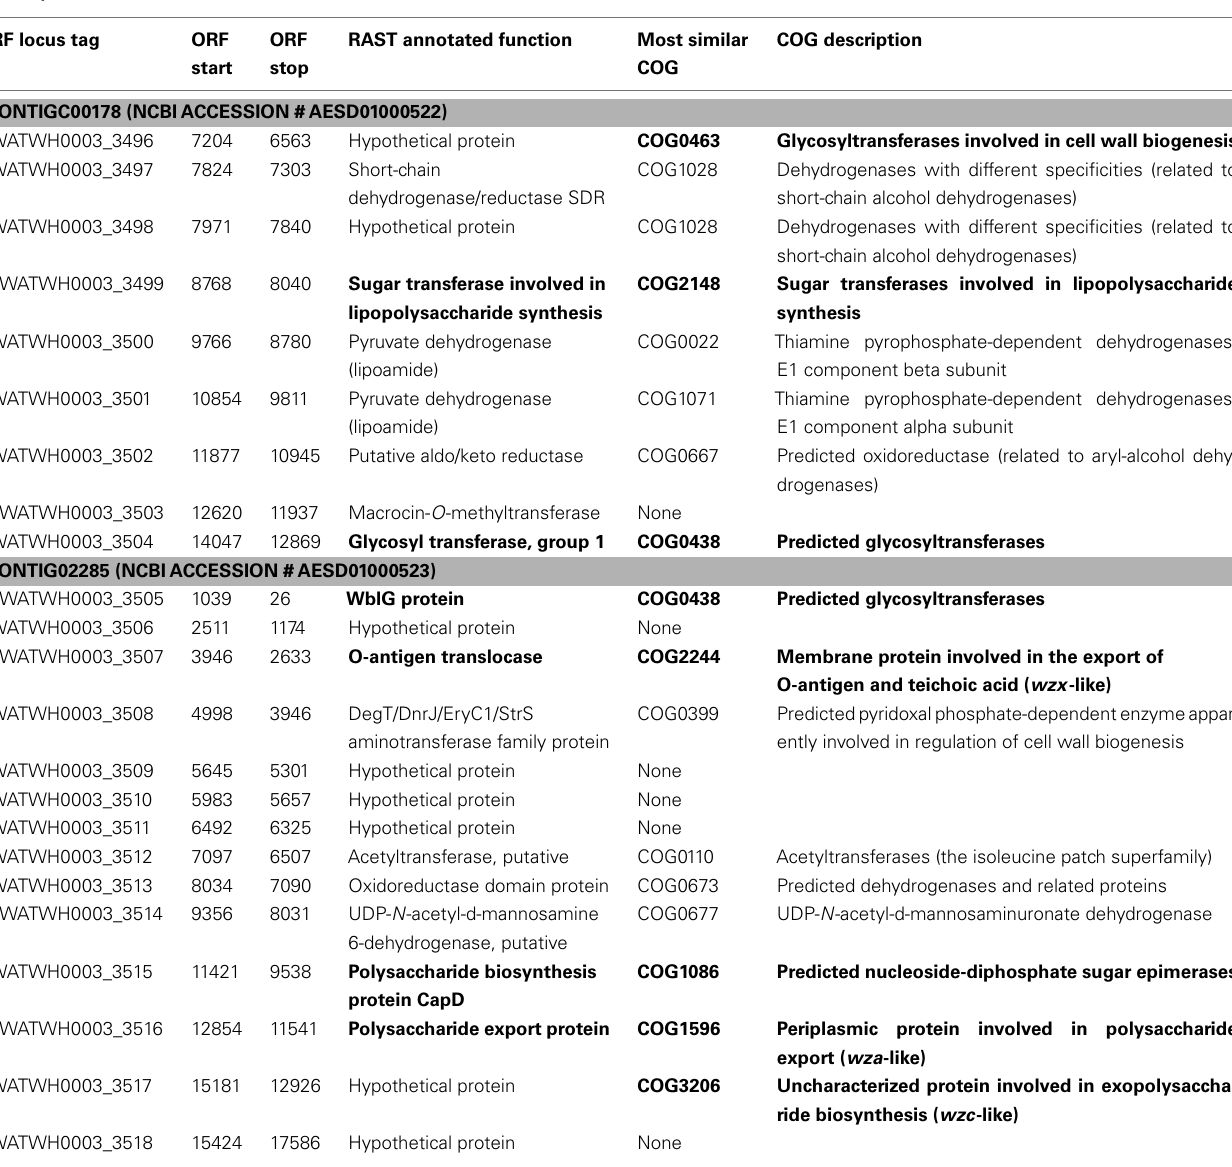
Table 2 | ORFs withinWH0003 strain-specific genome region. ORF locus